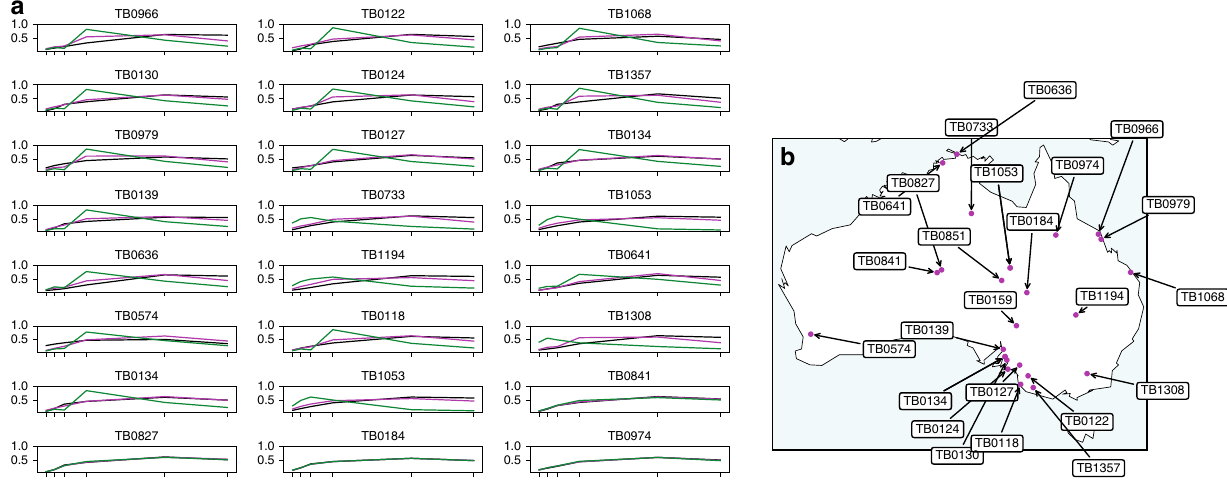
Fig. 6 Comparison of soil spectra to the Barest Earth spectra and a vegetated observation at various locations across Australia. a A selection of the NGSA sample spectra (black) across the continent compared to the Barest Earth (magenta) and the clear vegetated observation (green). Spectra have been normalised as x = jj x jj for observation vector x to remove parallel albedo shifts. b Sample locations where the sample identi fi ers are given and can be referenced back to the NGSA dataset.